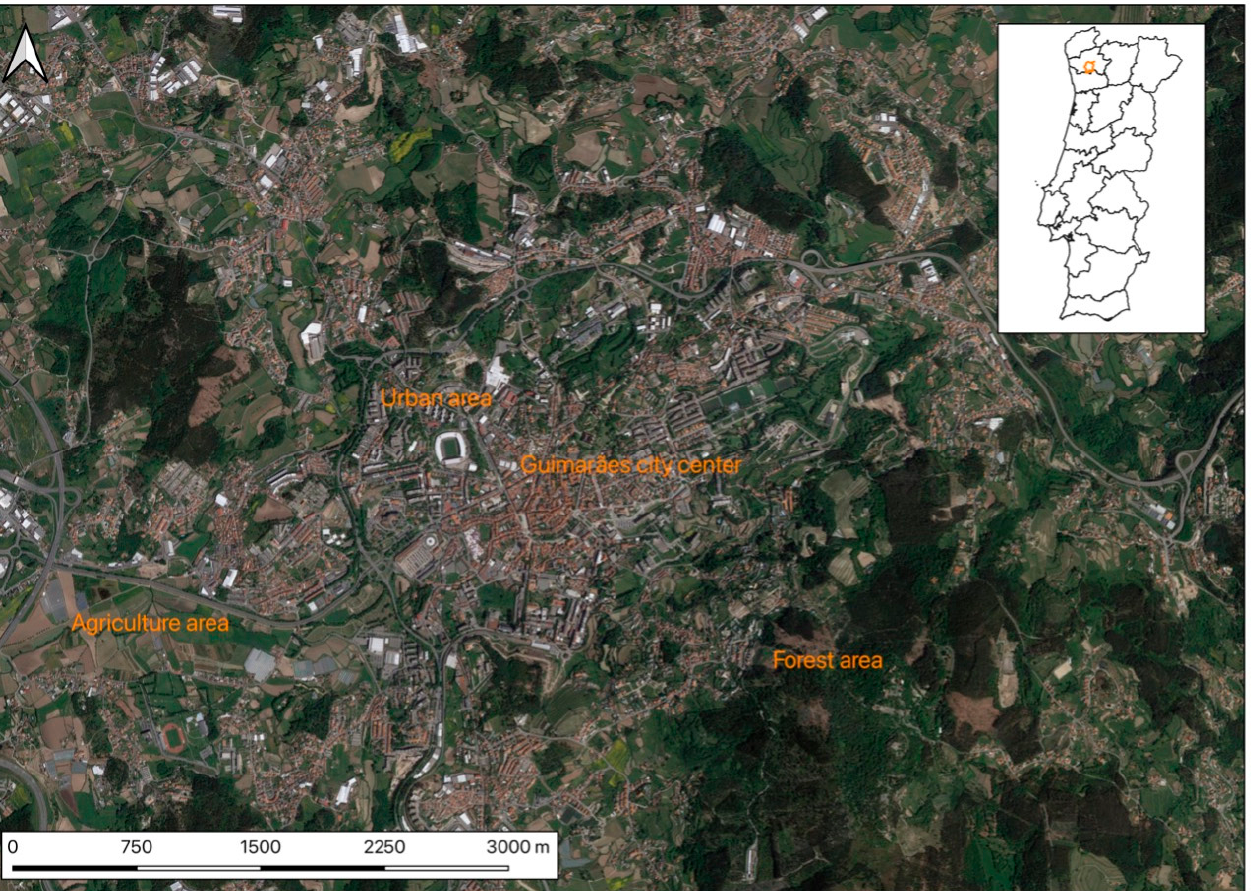
Figure 1. Alternation of different land use types in a region with dispersed population (Guimarães, Portugal). In Figure 1, where the city center of Guimarães is visible, there is an interweaving of the different types of land use, with an alternation between the urban, forest, and agriculture zones. Usually, urban areas are surrounded by agriculture areas, especially when located near water lines, which are more leveled. Forest areas dominate the most difficult parts of the relief, with urban areas occupying the gentler